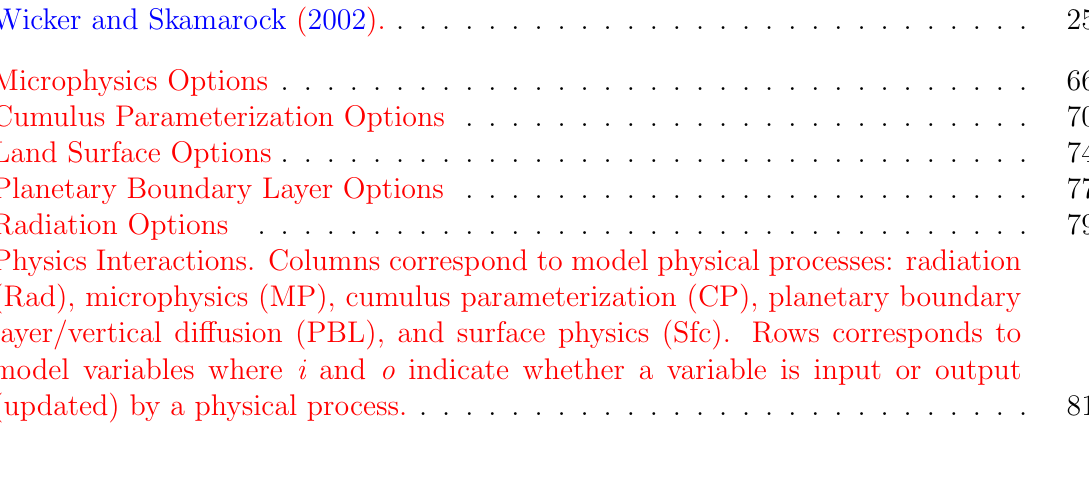
Maximum stable Courant numbers for one-dimensional linear advection. From